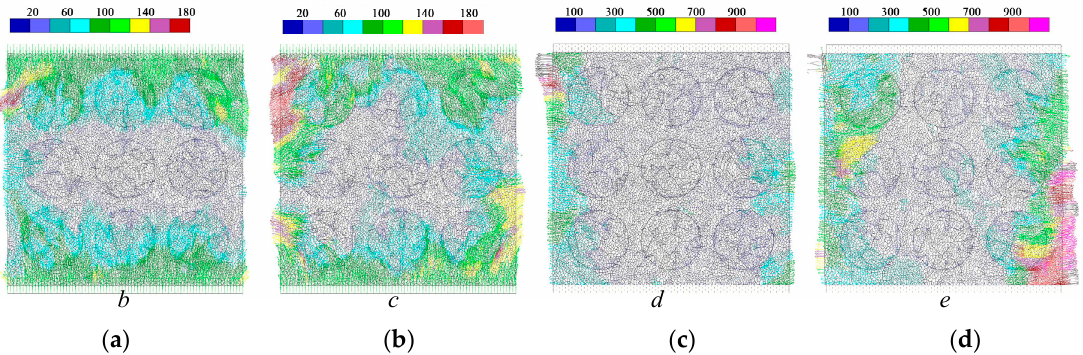
Figure 15. Velocity vectors of block centroid from numerical simulation (unit: mm/sec) ( a ) loading stage b ; ( b ) loading stage c ; ( c ) loading stage d ; ( d ) loading stage e .